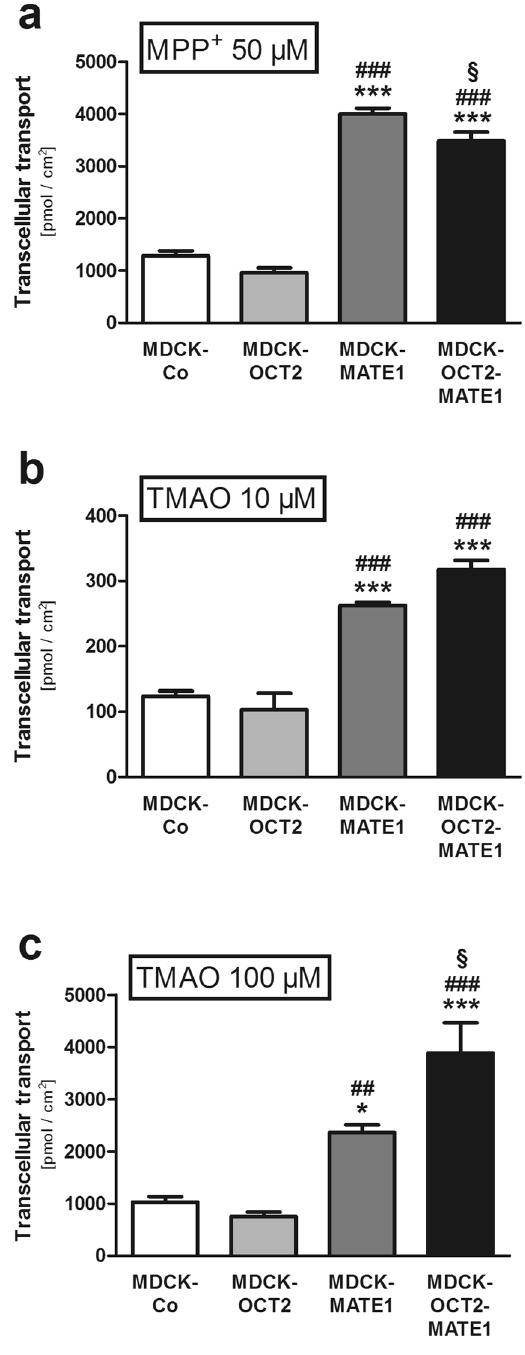
Figure 2. Transcellular transport of MPP + and TMAO [MPP + (50 µ M) ( a ), TMAO (10 µ M) ( b ), and TMAO (100 µ M) ( c )] across polarised grown monolayers of MDCK cells expressing OCT2 (MDCK-OCT2), MATE1 (MDCK-MATE1), or both OCT2 and MATE1 (MDCK-OCT2-MATE1) and control cells (MDCK-Co) after 60 min. Each data point is 2 × n = 3, mean ± SEM, * p < 0.05 vs. MDCK-Co, *** p < 0.001 vs. MDCK-Co, ## p < 0.01 vs. MDCK-OCT2, ### p < 0.001 vs. MDCK-OCT2, § p < 0.05 vs.